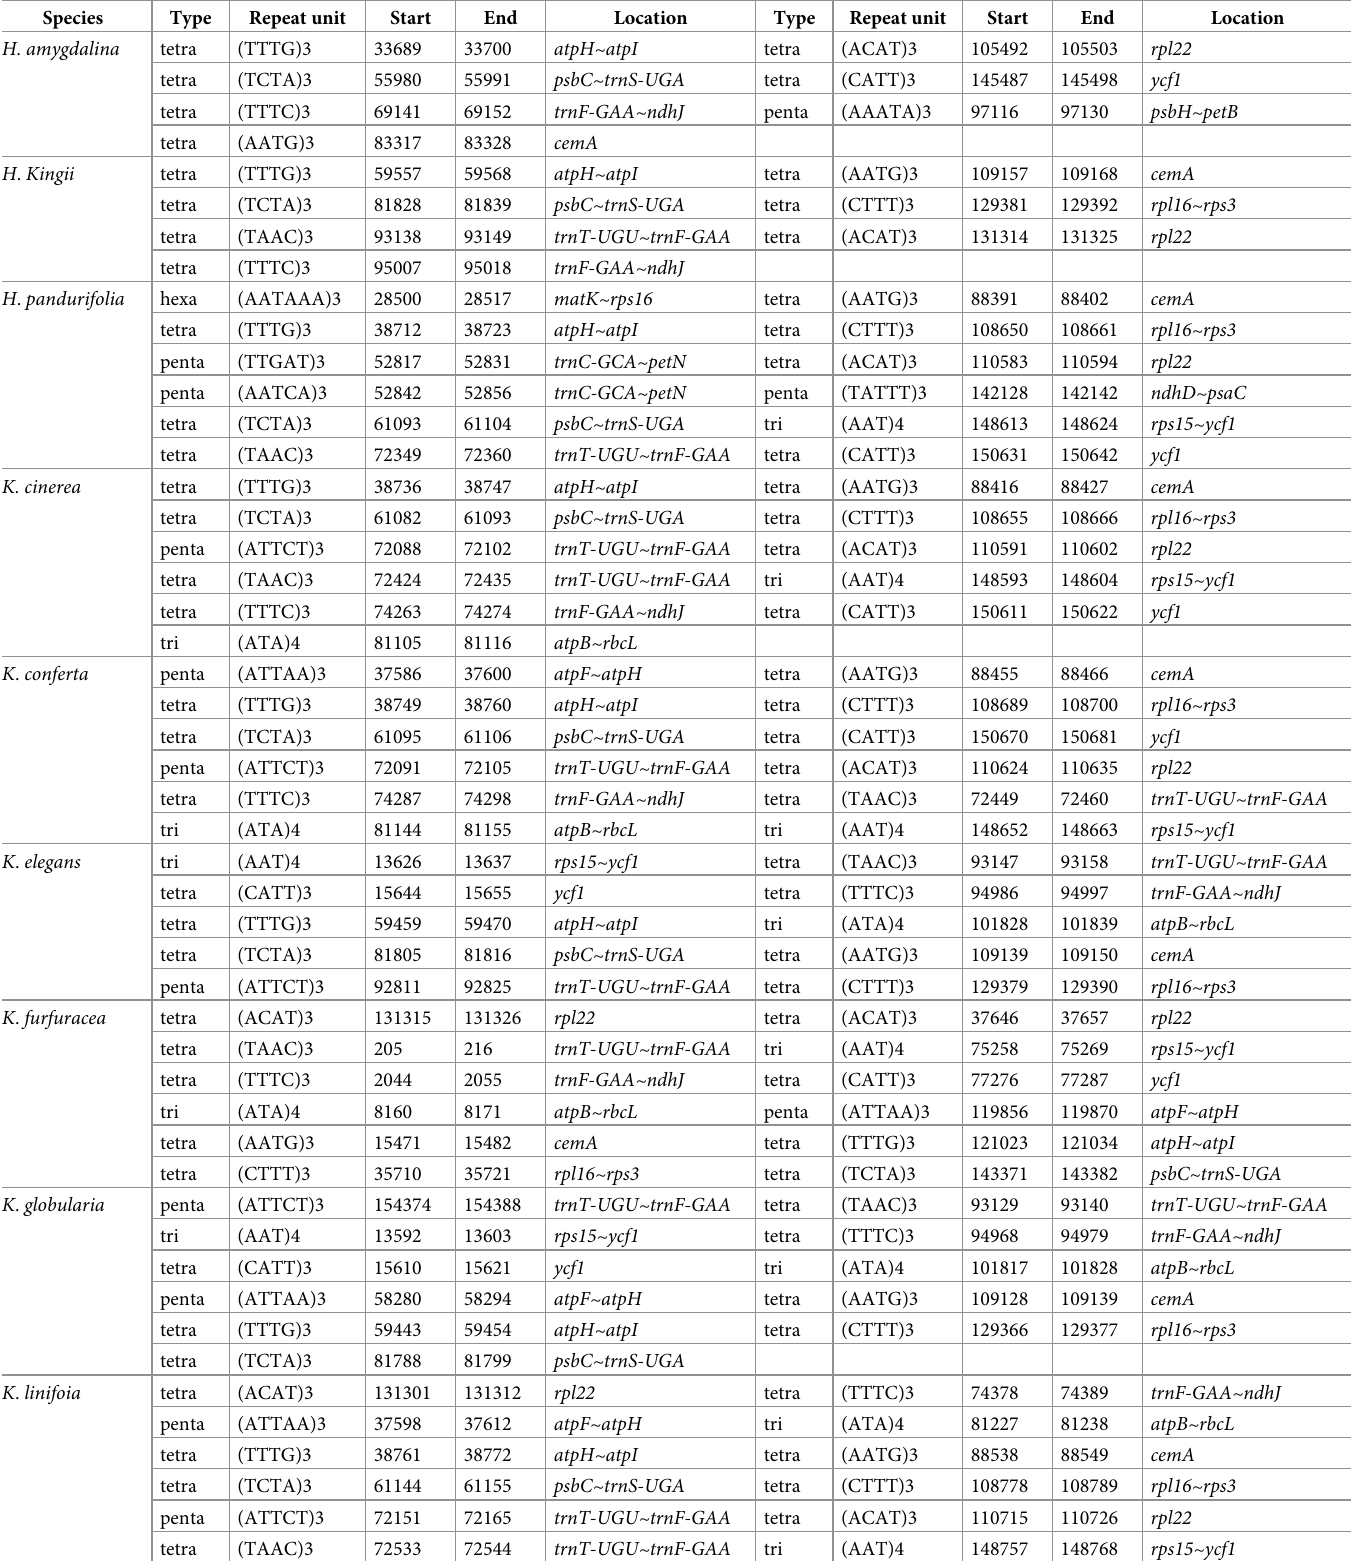
Table 4. SSR site information of ten species of Myristicaceae.